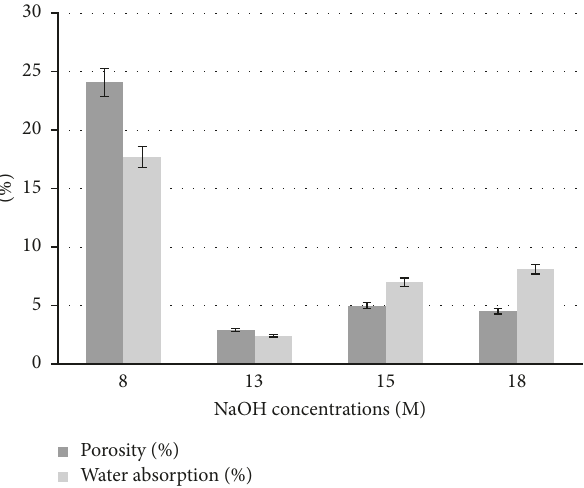
Figure 7: Open porosity and water absorption of geopolymer cement prepared with various NaOH